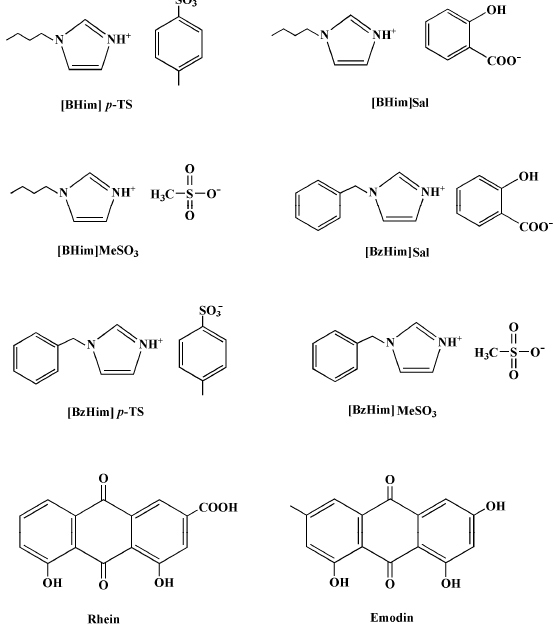
Figure 4. Chemical structures of PILs, rhein, and emodin.